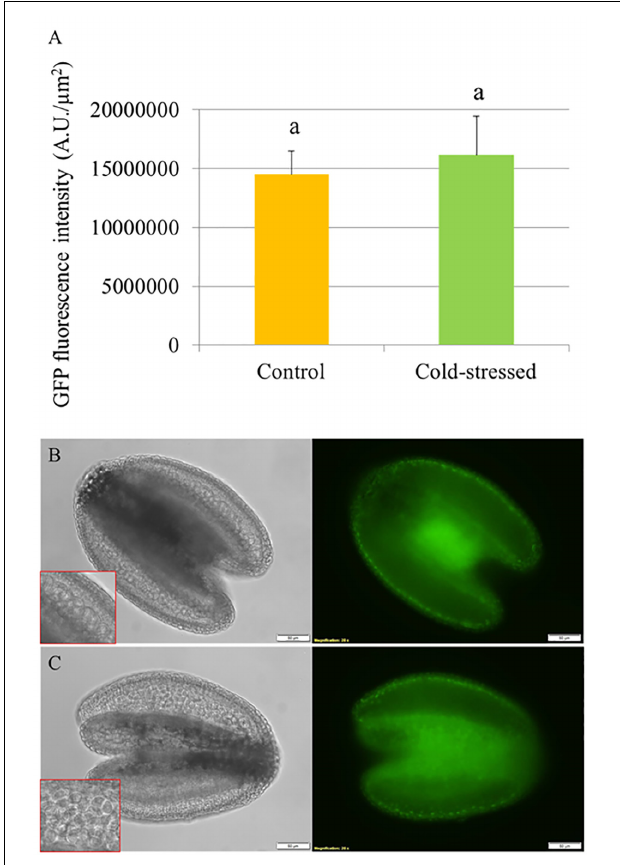
FIGURE 4 | Cold stress does not reduce the abundance of GFP-RGA in tetrad stage Arabidopsis anthers. (A) Histogram showing the GFP fluorescence intensity in tetrad stage anthers under cold stress. Five biological replicates were performed and Student’s t -test was used for significance analysis with significance level (alpha) = 0.05. (B,C) Expression of pRGA::GFP-RGA in tetrad stage anthers under normal